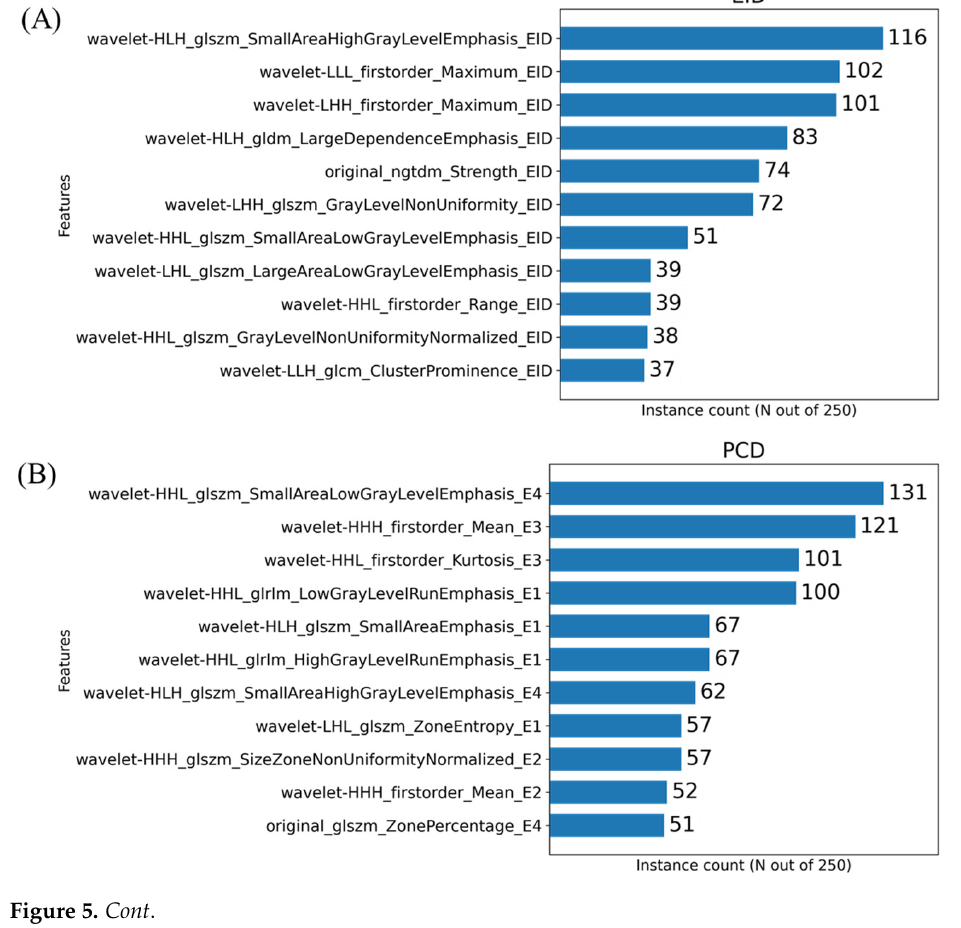
Figure 5. Histograms resulting from the MRMR-based feature selection process for the three imag- ing sets i.e., EID ( A ), PCD ( B ) and material decomposition ( C ). The histograms show the frequency of a given RF selection throughout the repeated cross validation folds. For example, a feature that was found to be significant for all 5-folds across all 50 repeated samples would have a value of 250. The feature names are written in a form output from PyRadiomics with an appended suffix used for identifying the image source. Each name is the union of the following: image transform, feature class, feature name, image type. For example, the RF representing the calculated 3-dimensional sphericity from the raw EID images, with no wavelet decomposition, would be written as “origi- nal_shape_Sphericity_EID”. Only the top 11 most repeated features are shown on these plots for readability.